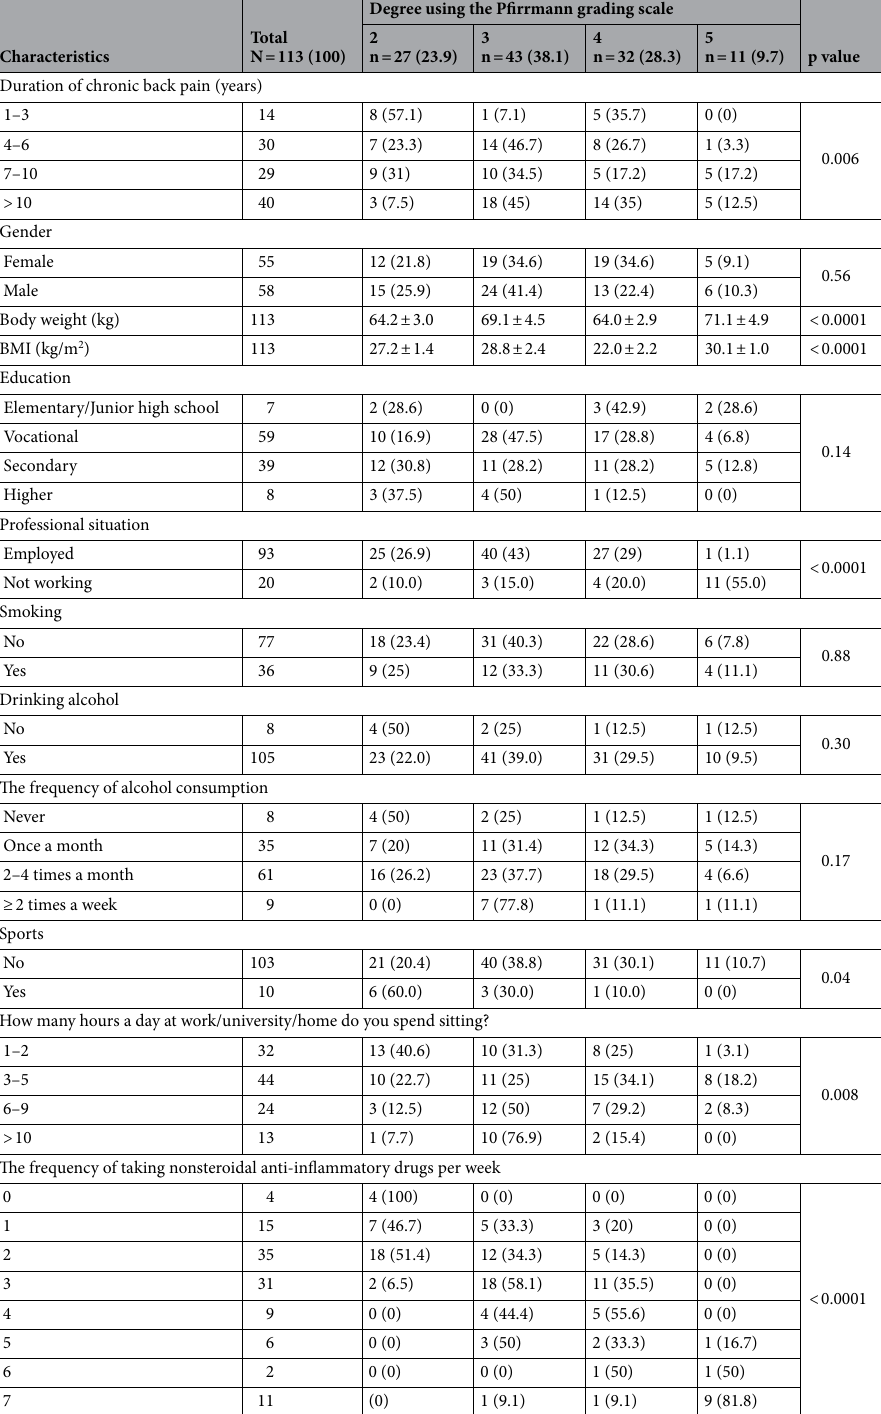
Table 1. Characteristics of the patients qualified for microdiscectomy due to degeneration of the intervertebral disc of the L/S spine section. Qualitative data are presented as numbers and percentages; p values were determined by the chi-squared test. Quantitative data are presented as the mean ± standard deviation; p values by